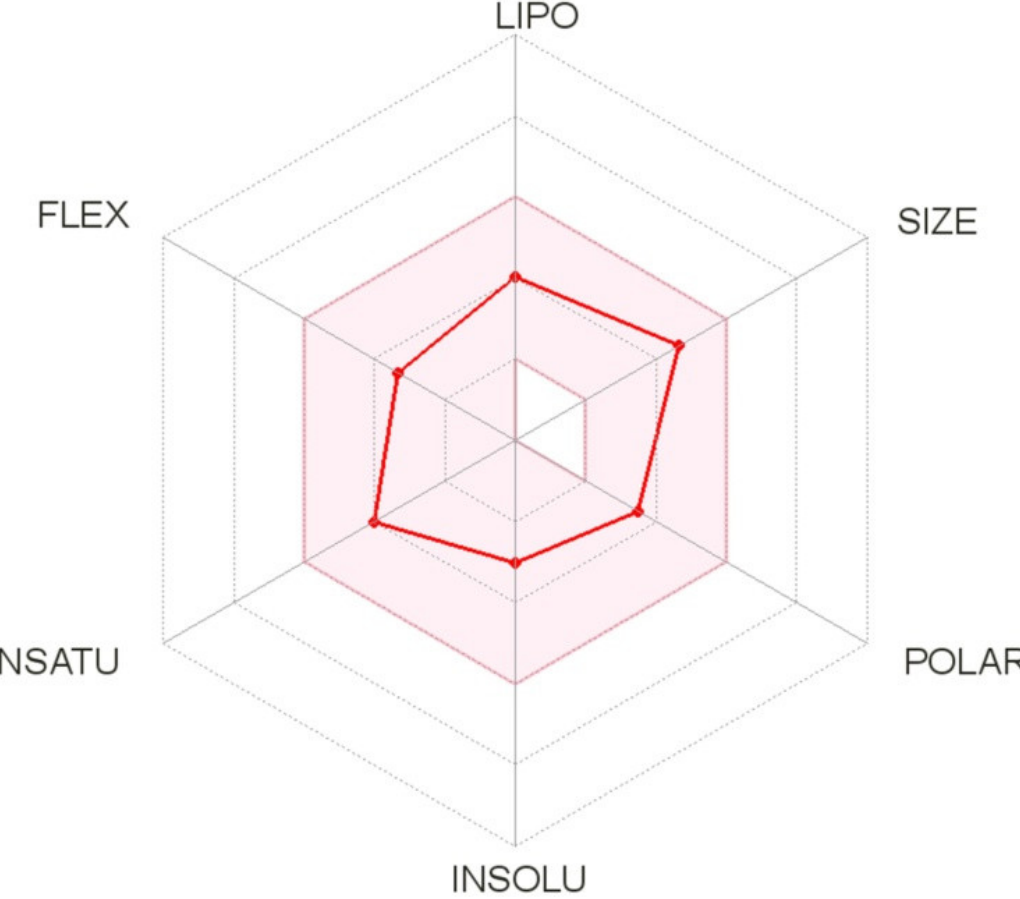
Figure 5. The bioavailability radar of compounds C-11 (LIPO—lipophilicity, POLAR—polarity, INSOLU—solubility, FLEX—flexibility, INSATU—saturation of the molecule).